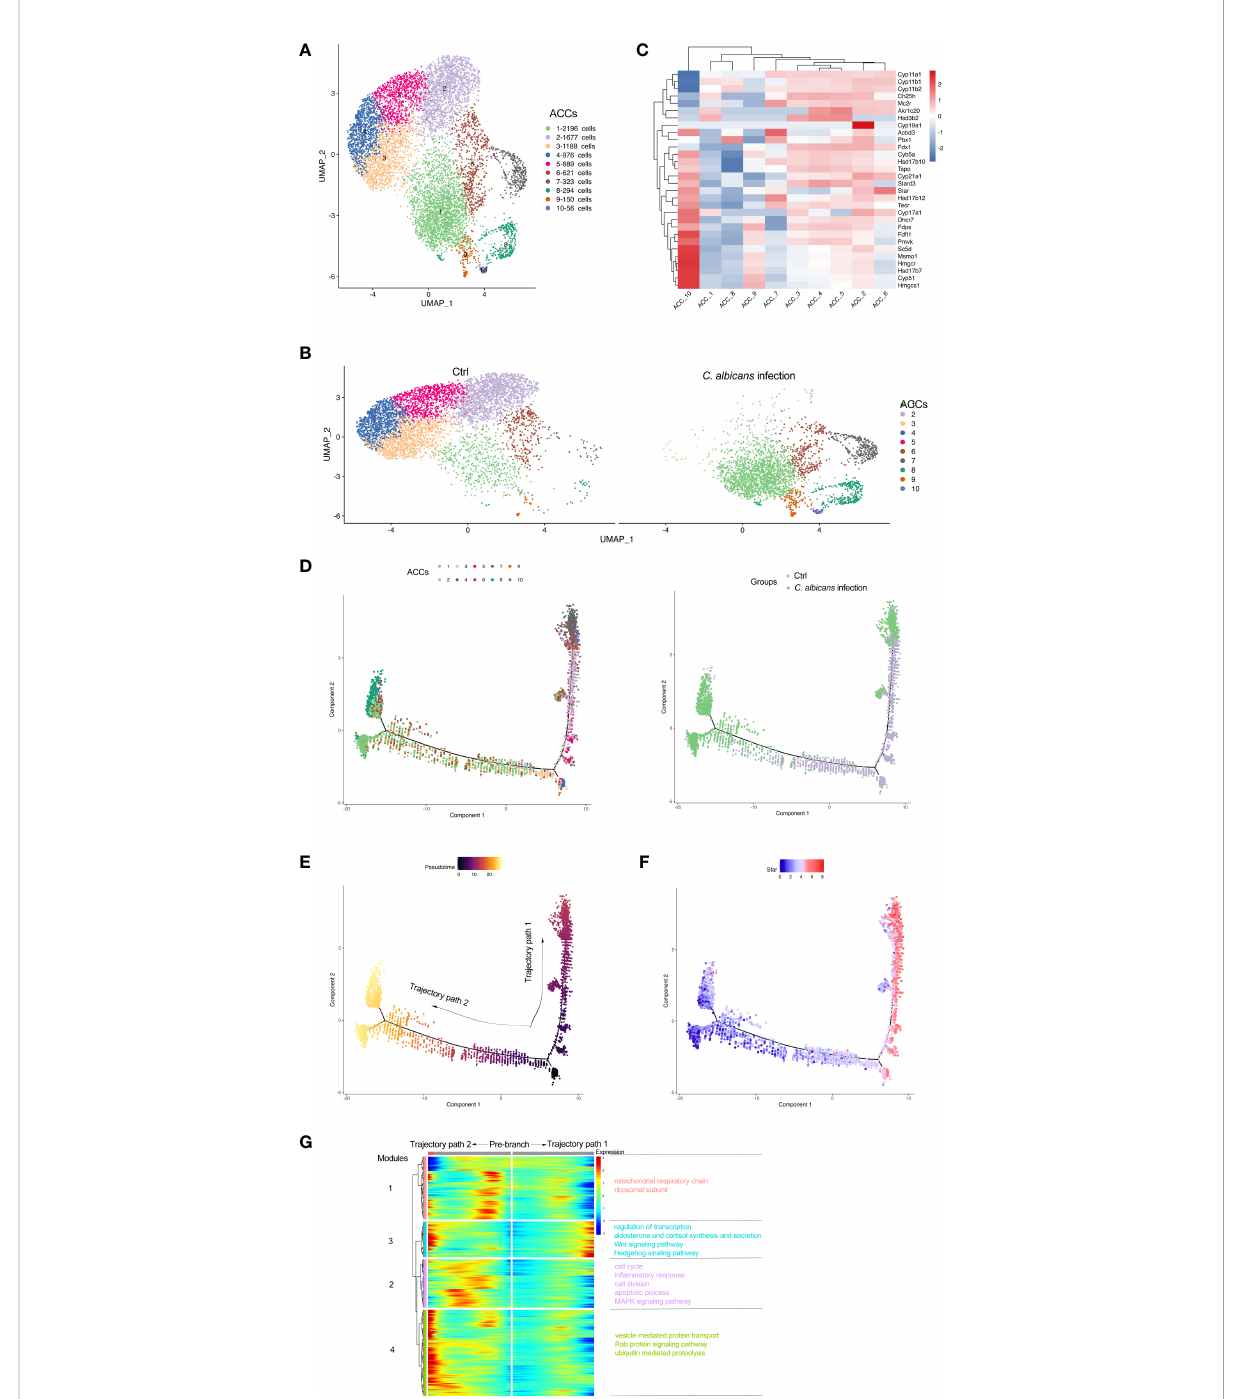
FIGURE 3 Subclusters and pseudo-time trajectory of adrenocortical cells in C. albicans- infected mice and uninfected controls. (A) Adrenocortical cells from both groups were pooled and subjected to subclustering on the UMAP plot. (B) The different distributions of the adrenocortical subclusters (ACCs) originating either from infected or uninfected animals shown by UMAP plots. (C) Heatmap of the expression patterns of the steroidogenesis associated genes across the 10 AACs. (D) The transitions of adrenocortical cells during candidiasis progression along the pseudo-time trajectory, shown by ACCs (left) and groups (right). (E) The pseudo-time trajectory in case the transition states corresponding to ACC3 and ACC4 were designated as the beginning. (F) Expression pattern of Star along the pseudo-time trajectory. Each point indicates the log-normalized expression level in a single cell. (G) Heatmap of different modules of DEGs along the pseudo-time trajectory. Representative signi fi cantly enriched GO and KEGG functional processes were